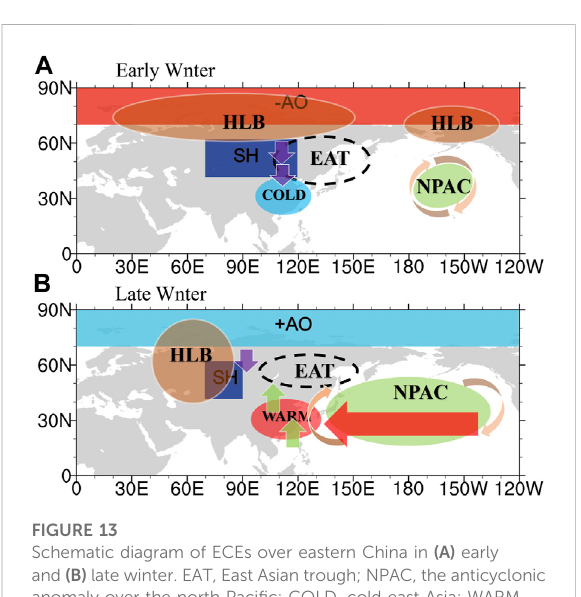
FIGURE 13 Schematic diagram of ECEs over eastern China in (A) early and (B) late winter. EAT, East Asian trough; NPAC, the anticyclonic anomaly over the north Paci fi c; COLD, cold east Asia; WARM, warm east